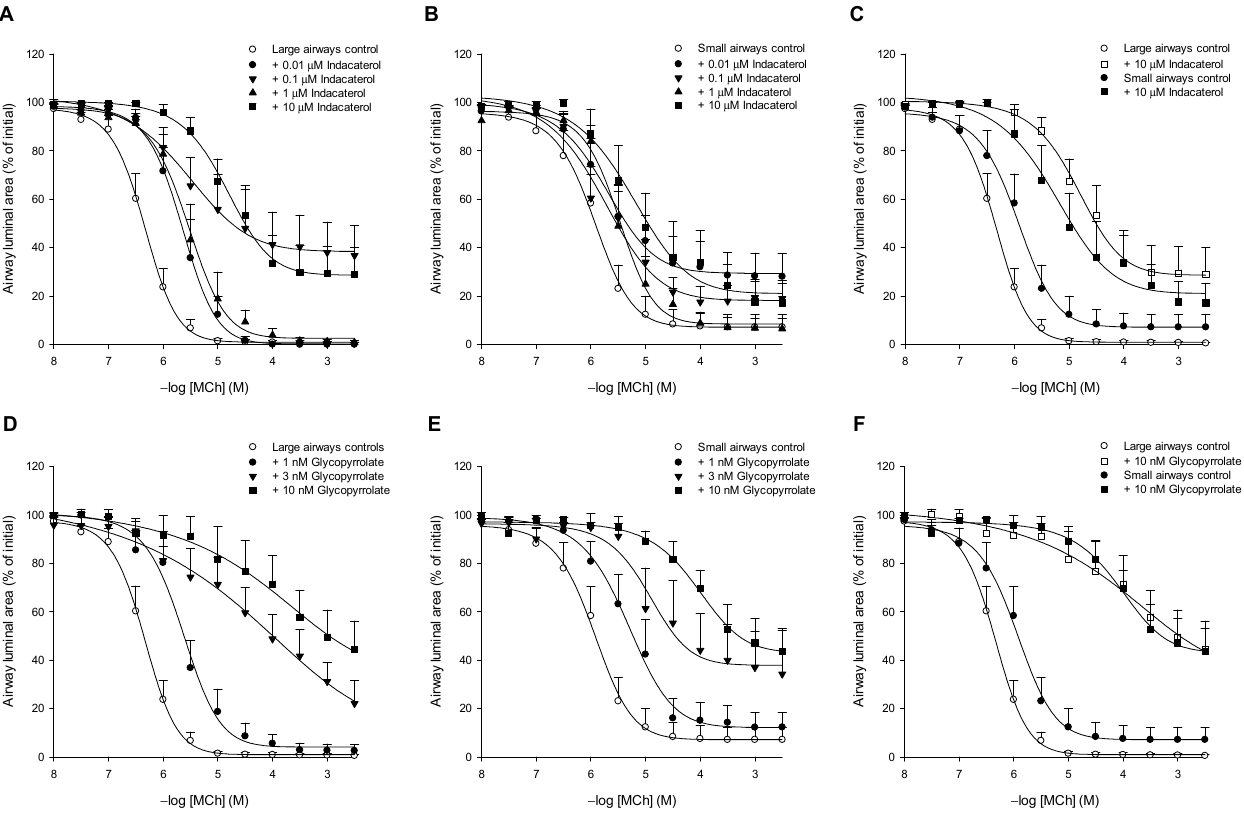
Figure 1. The effect of the β 2 -agonist indacaterol ( A – C ) and the anticholinergic glycopyrrolate ( D – F ) on methacholine- induced constrictions of large ( A , D ) and small ( B , E ) airways in guinea pig lung slices. Comparison of maximal drug effectiveness on large and small airways is shown in panels C and F. Lung slices were incubated with increasing concentra- tions of indacaterol (0.01, 0.1, 1 and 10 μ M) or glycopyrrolate (1, 3 and 10 nM) and the constriction of large (>150 μ m) and small (<150 μ m) airways to increasing concentrations of methacholine (MCh) was determined by measuring the luminal area as a percentage of baseline. Data are represented as means ± SEM of 5–10 guinea pigs (see also Table 1). Table 1. Effects of indacaterol and glycopyrrolate on methacholine-induced airway constriction of large and small airways in guinea pig lung slices.